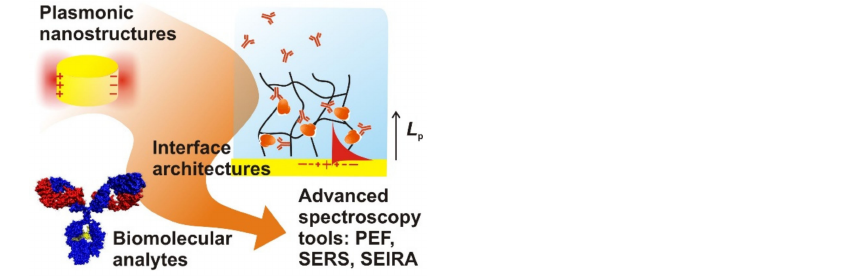
Figure 1. Plasmonic nanostructures for the amplification of weak optical spectroscopy